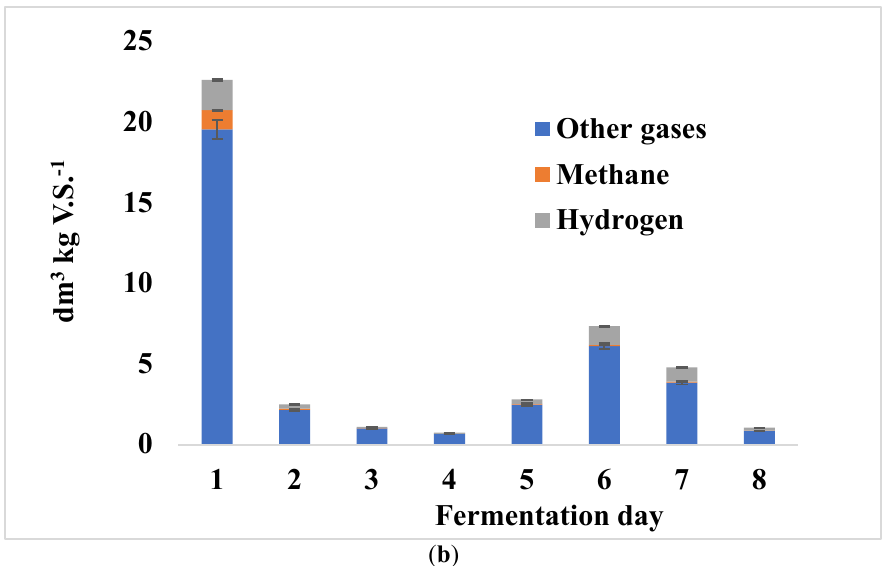
Figure 4. Daily hydrogen production of treated 4% ( a ) and 6% ( b ) SCG during 8 days of fermentation at pH 5.5. For details see the Materials and Methods section.